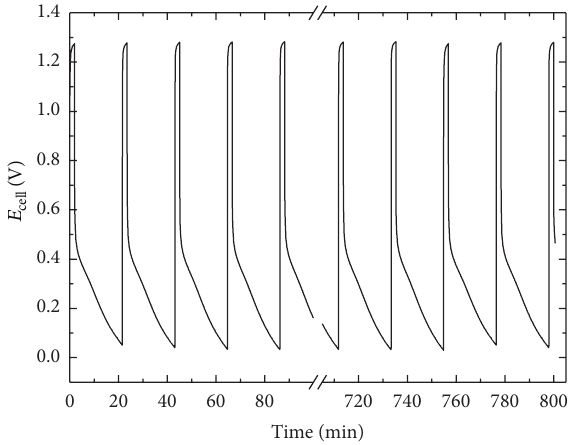
Figure 8: Performance tests of a microenergy systems with sput- tered Pd as hydrogen storage; electrolysis/charge is carried out at 𝐼 = 5mA, 𝑡 = 2min; fuel cell/discharge is carried out at 𝐼 ch 𝑡 = dch